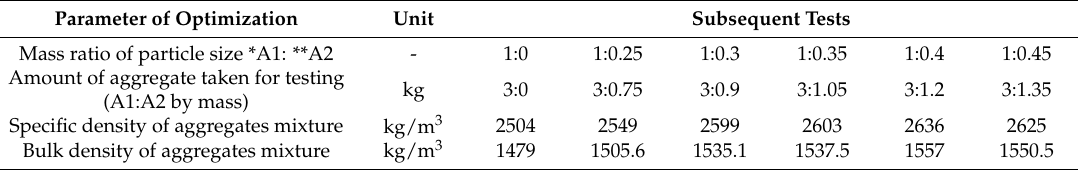
Table 2. The results of a study to determine the optimal proportion of ceramic aggregate fraction. Parameter of Optimization